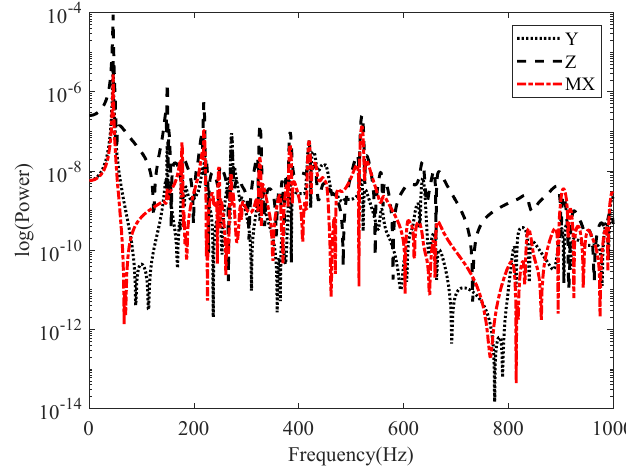
Figure 9. Vibration power flow of P2 in the z-direction.